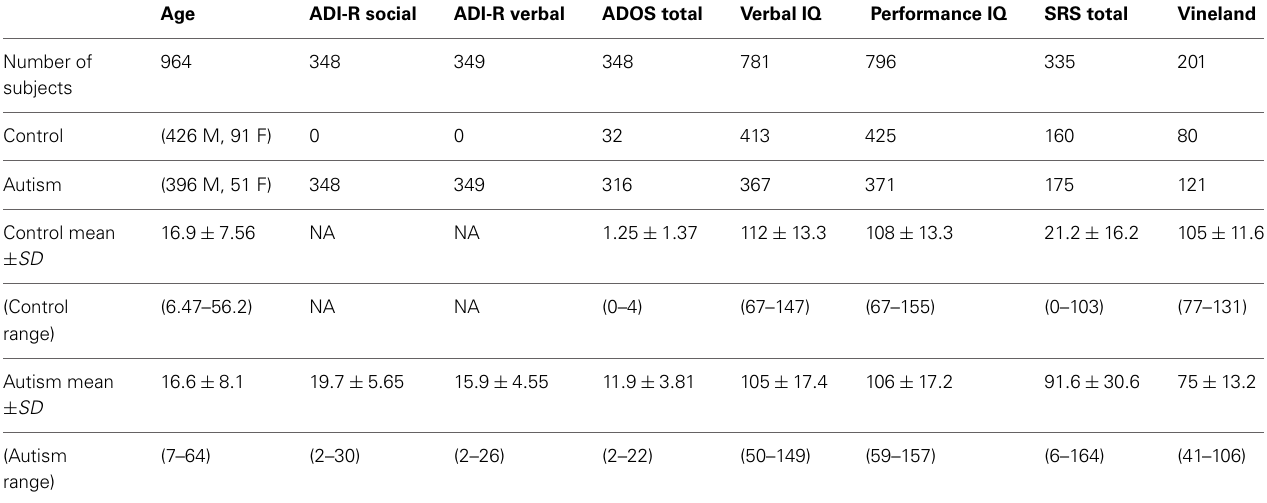
Table 1 | Subjects included from the ABIDE sample with demographic